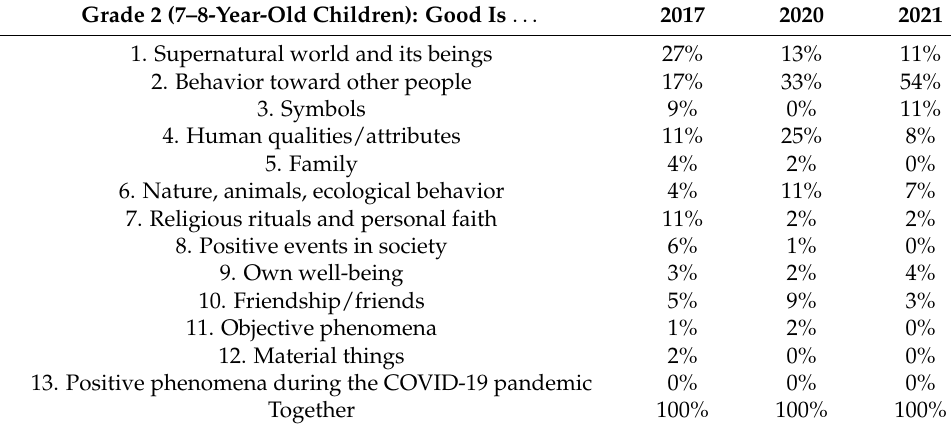
Table 3. The concept of good by 7–8-year-old children (Grade 2). Grade 2 (7–8-Year-Old Children): Good Is . . .